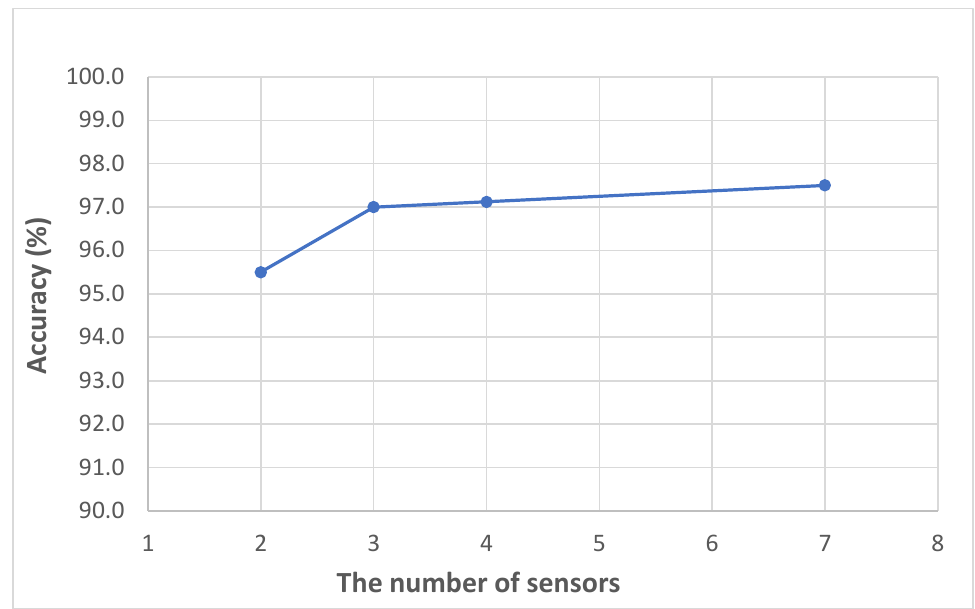
Figure 16. Comparison of training accuracy based on the number of sensors used.